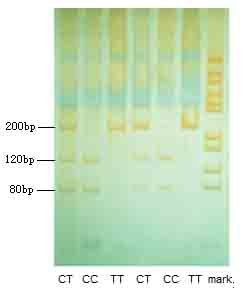
Gene type analysis of PPARγ gene C161→T. M: PGEM-7Z(+)HaeIIIDNA molecular marker